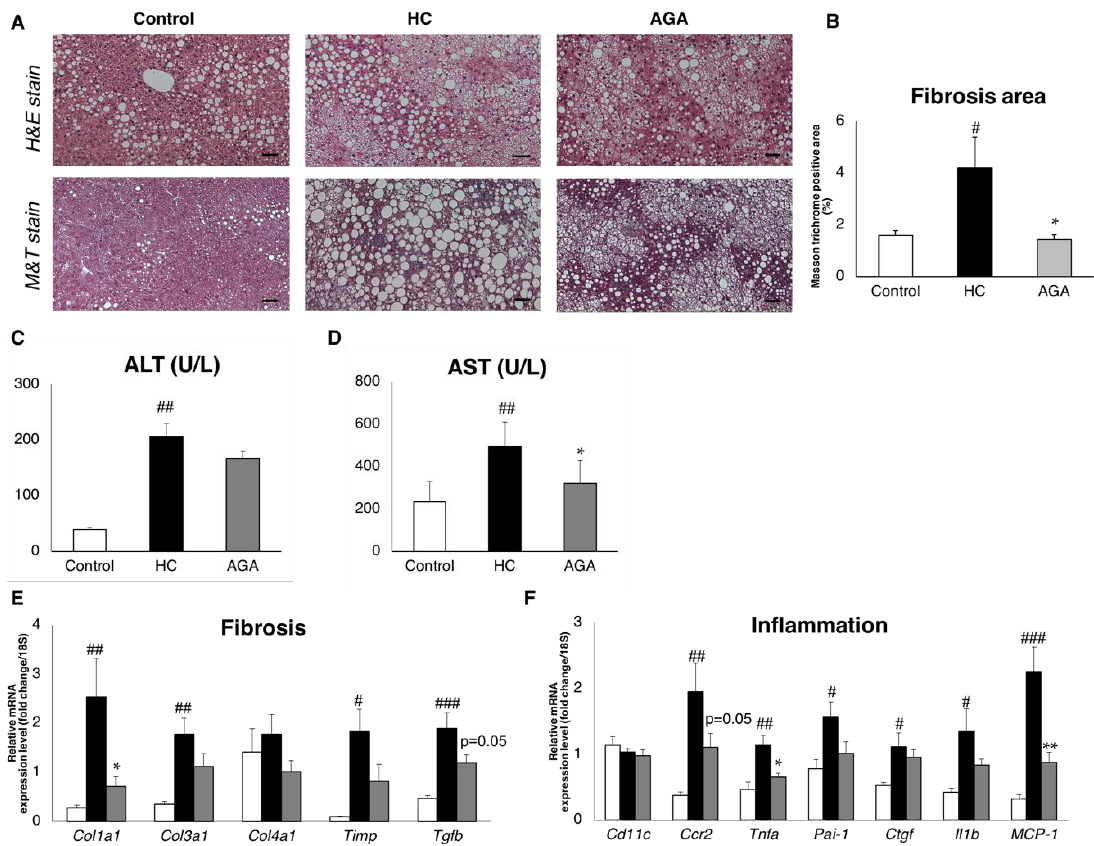
Figure 3. Agaricus brasiliensis KA21 (AGA) prevents liver fibrosis and inflammation. Control diet (Control), high-fat and high-cholesterol diet (HC), and high-fat and high-cholesterol + 5% AGA. ( A ) Histological staining of the liver (hematoxylin and eosin (H&E) stains’ fat droplets, M&T stains’ collagen fibers), Azan staining, and Sirius red staining; ( B ) evaluation of fibrosis area. Percentage of positive area showing staining within the threshold range to total staining area; ( C ) serum alanine aminotransferase (ALT); ( D ) serum aspartate aminotransferase (AST); ( E ) mRNA expression analysis of fibrosis in the liver ( n = 7), normalized by using 18S; ( F ) mRNA expression analysis of inflammation in the liver ( n = 7), normalized by using 18S. Data are presented as the mean ± SEM values. n = 7 mice per group. Statistical analysis was performed using one-way ANOVA, followed by Bonferroni’s post-hoc test. # /* p < 0.05; ## /** p < 0.01, ### p < 0.001 versus mice in the HC group ( # significant differences for HC versus Control, * significant differences for HC versus AGA).